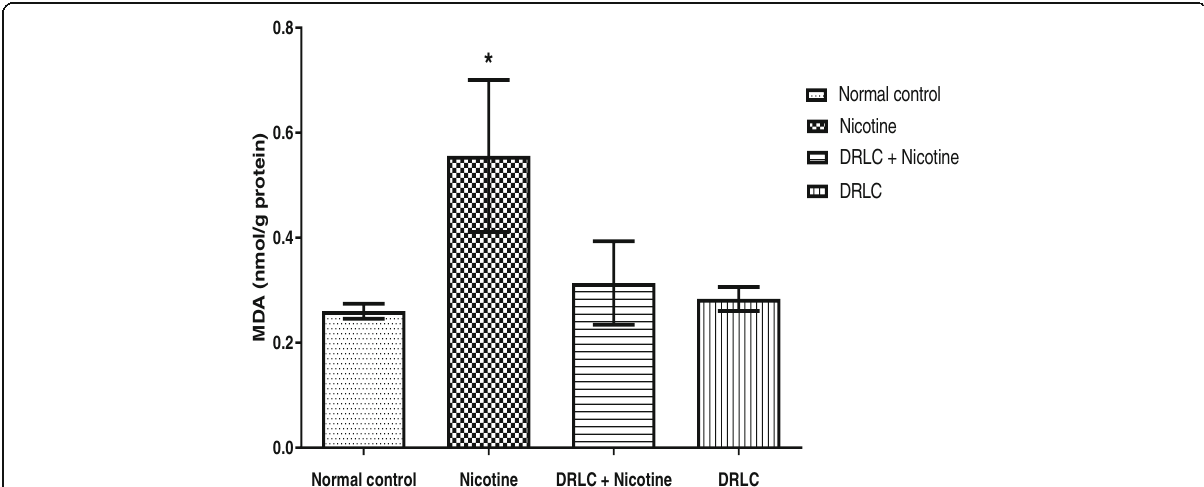
Fig. 5 Charts showing MDA levels in experimental animals. Values are mean ± SEM; N = 5. *Statistically different from normal control, D-ribose L - cysteine and DRLC